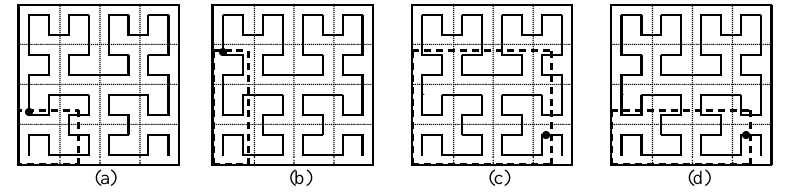
2 q (cid:8) ; (b) and (d)